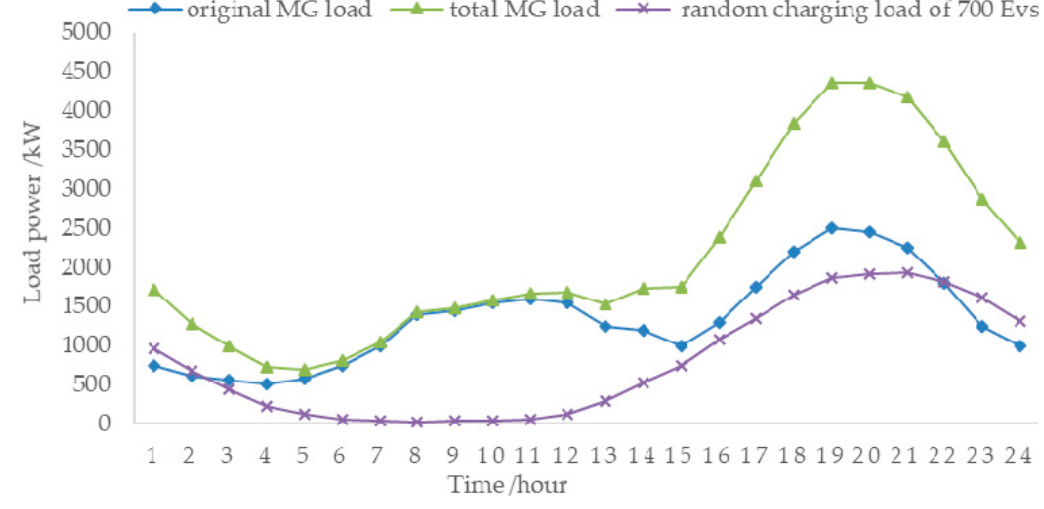
Figure 13. Random EV charging load curve.